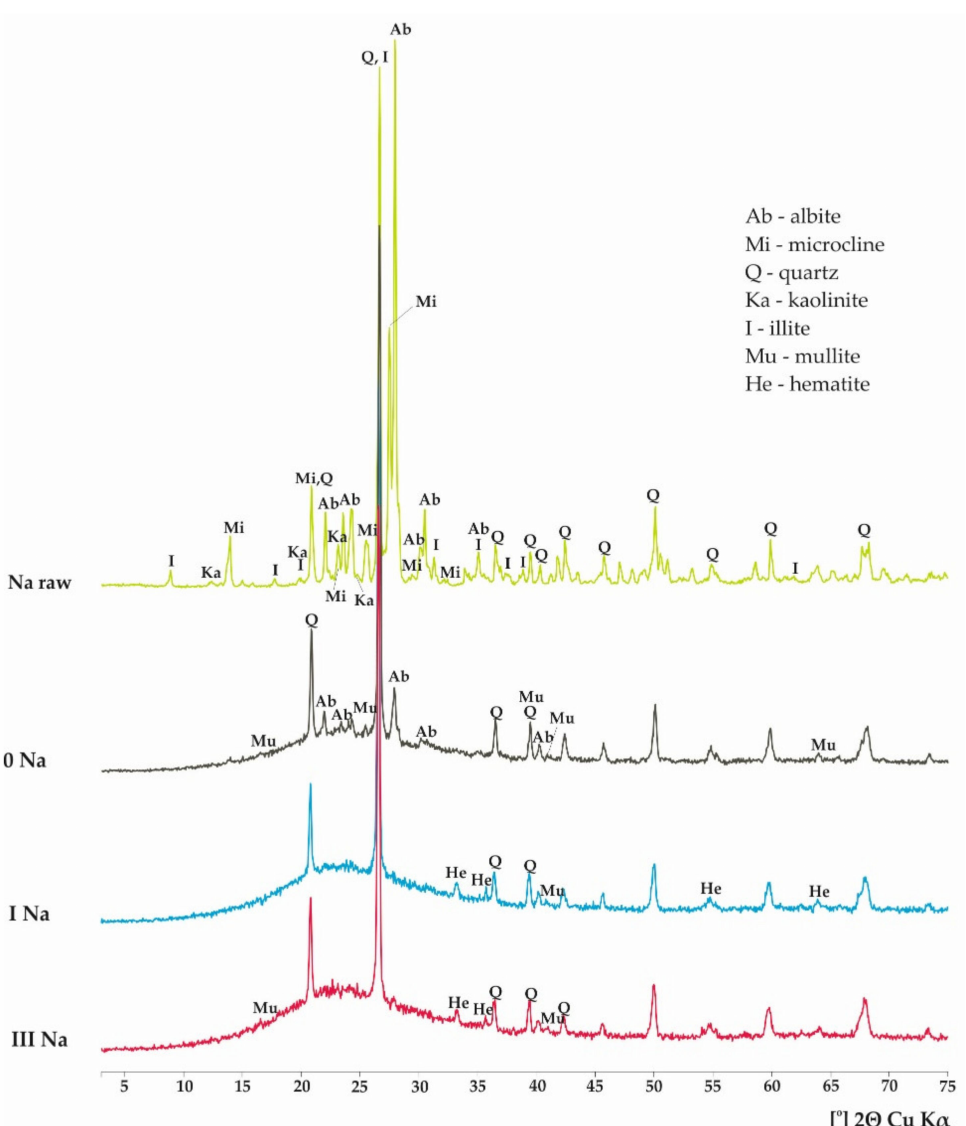
Figure 2. XRD patterns of sodium feldspar-quartz samples in a raw state / unfired (Na raw), as well as the samples after firing: without synthetic pigments addition (0 Na), as well as doped with 1.5% Fe 2 O 3 (I Na), and with 1.5% Fe 2 O 3 + 0.5% TiO 2 (III